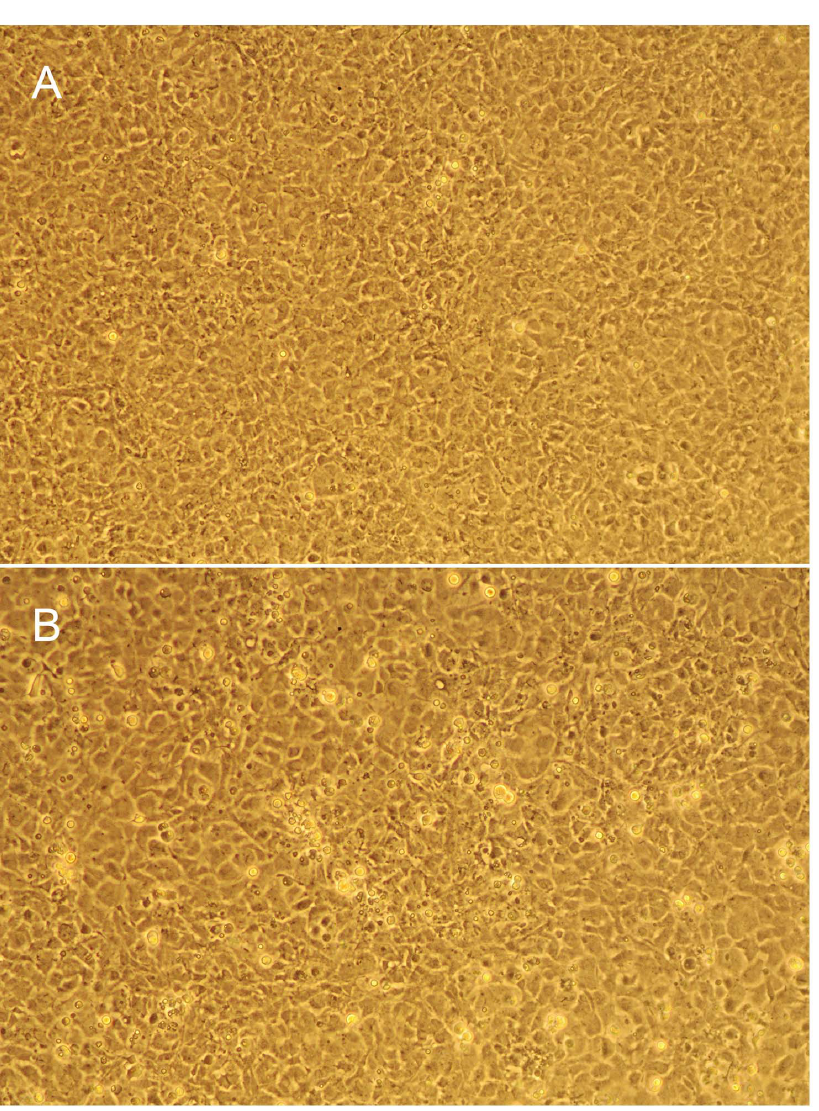
Figure 1. Fathead minnow picornavirus infected cell culture. A) Healthy epithelioma papulosum cyprini cells (EPC), B) EPC cells incubated at 22 u C, 6 days post-inoculation with fathead minnow picornavirus (FHMPV-09).